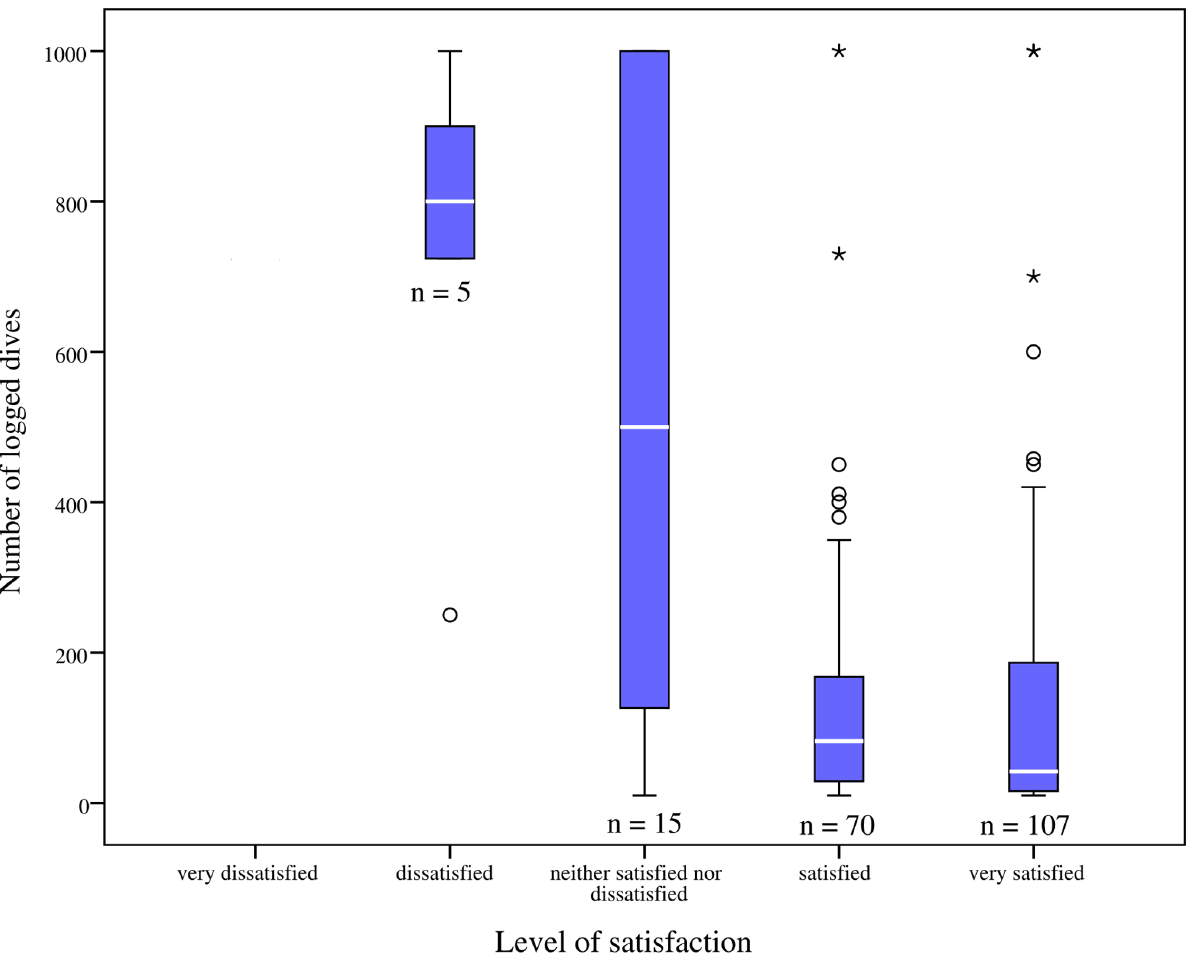
Figure 3. Divers’ satisfaction of artificial reef diving according to number of dives respondents had logged. Boxes represent the inter- quartile range that contains 50% of values. The median value is represented by a line across the box. The whiskers extend to the 5 th and 95 th percentiles and circles and stars outside the box plots are outliers. Sample size is represented by numbers below each box.